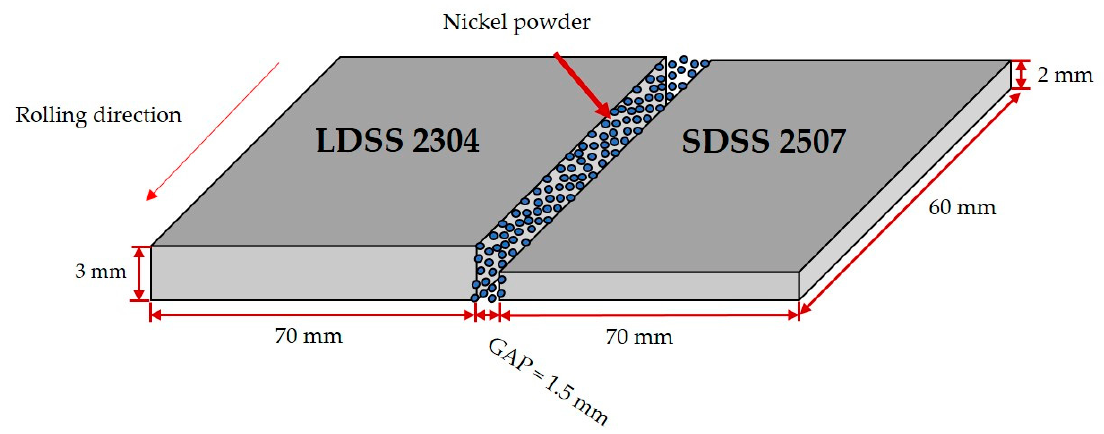
Figure 1. Scheme of the dissimilar duplex stainless-steel butt joint.